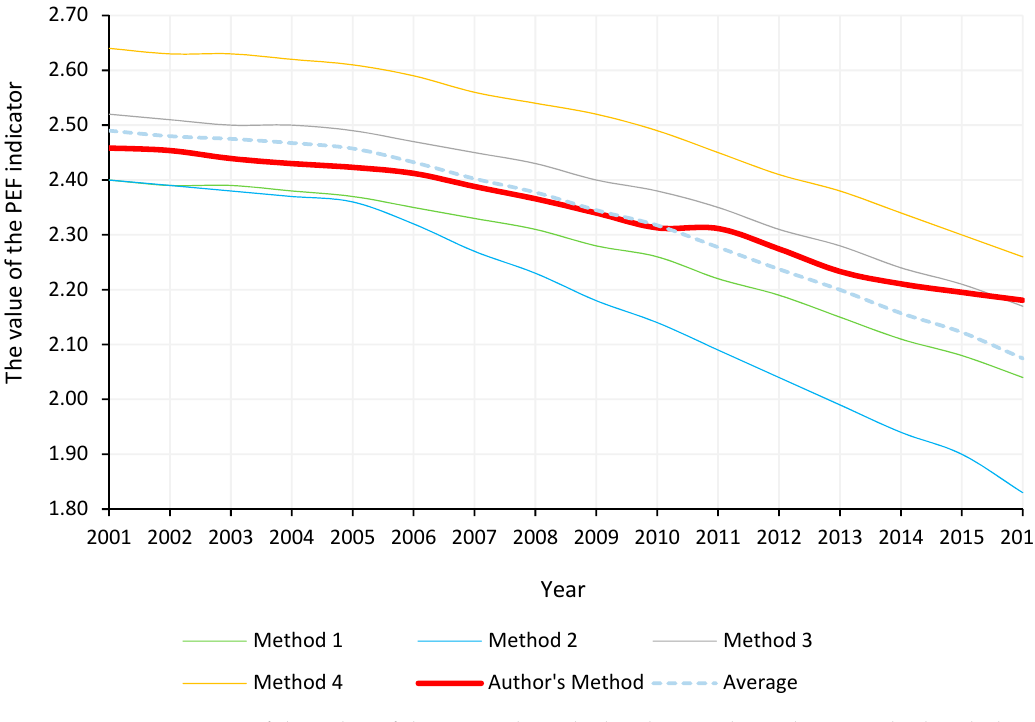
Figure 4. Comparison of the value of the PEF index calculated using the author’s method with the values resulting from the calculations proposed by the Fraunhofer-Institut in the years 2001–2016.